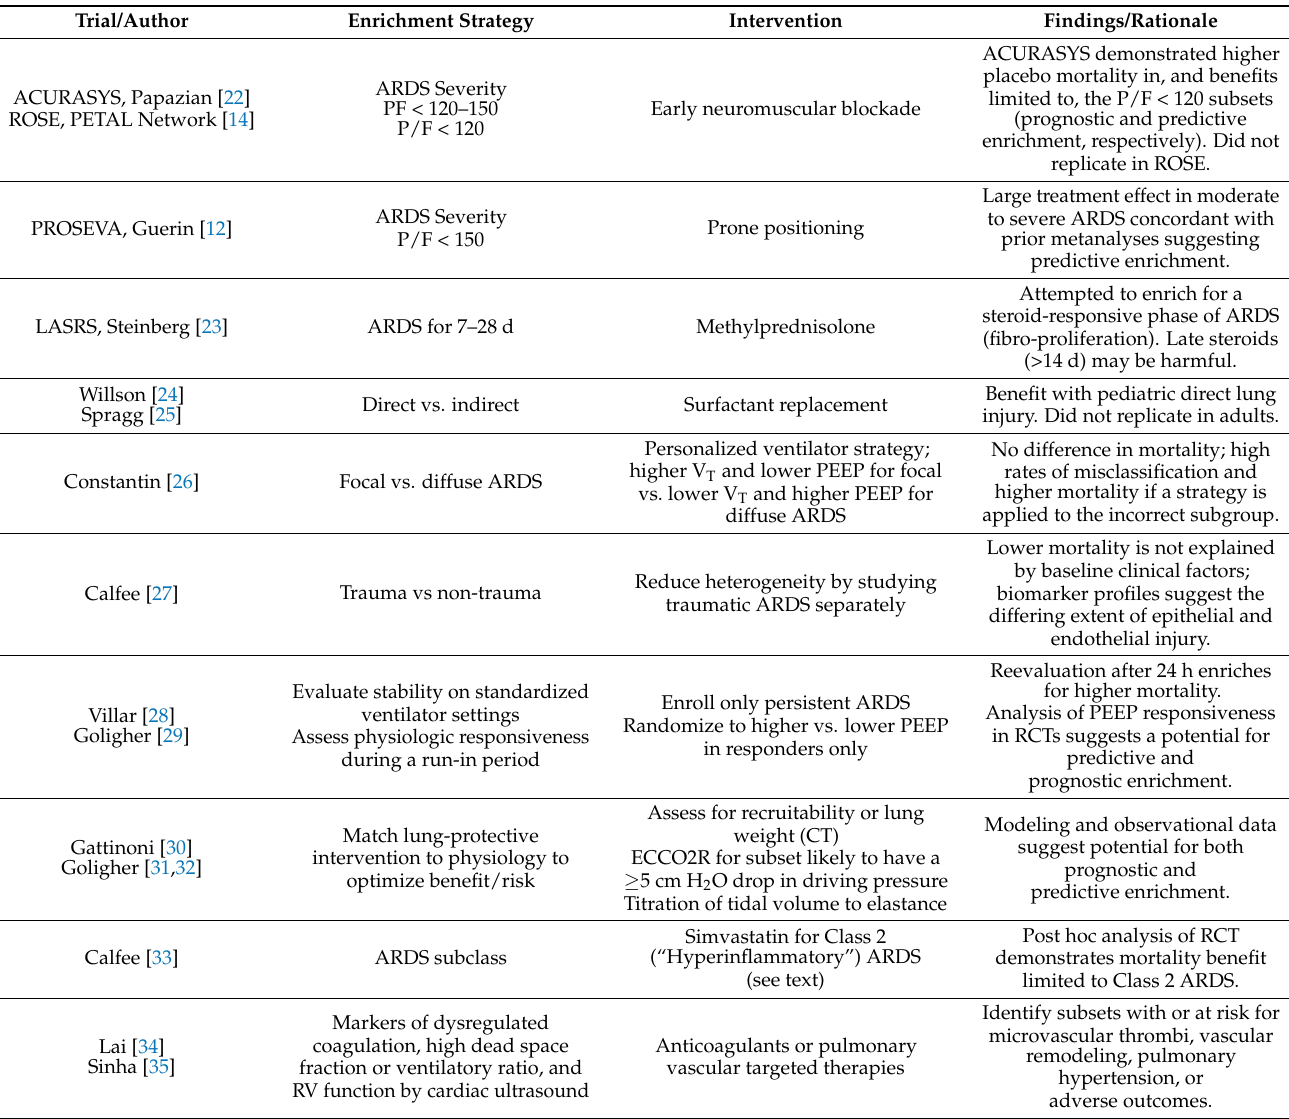
Table 1. Selected enrichment strategies used or proposed for ARDS clinical trials. Reprinted